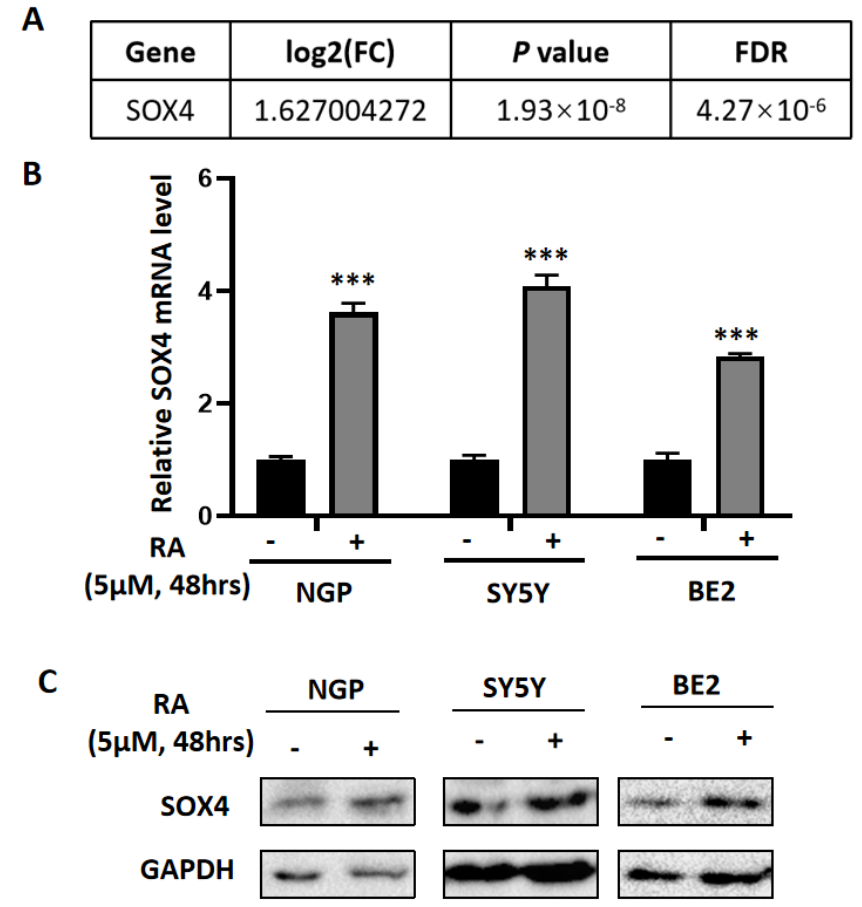
Figure 2. RA treatment increased the expression of SOX4 in NB cells. ( A ) The expression of SOX4 was increased from our previous RNA-Seq data (NGP cells treated with RA for 48 h). RT-qPCR ( B ) and Western blot ( C ) were performed to detect the expression of SOX4 in RA-treated (5 µ M, 48 h) NGP, SY5Y, and BE2 cells. Control vs. RA treatment, *** p < 0.001. The uncropped western blots have been shown in Figure S3.